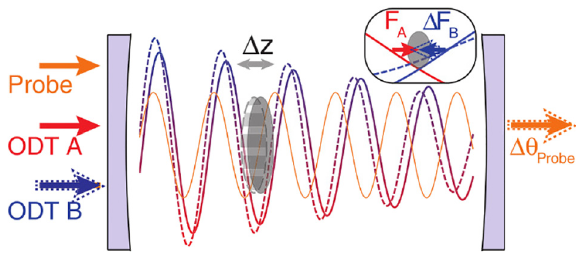
Figure 13: Schematic of gas mass center motion detection with the optomechanical system based on the F–P cavity [123].